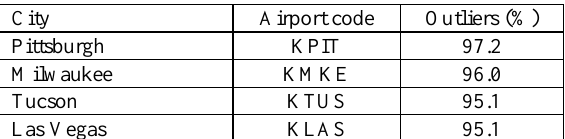
Table 1. Percentage of outliers in the SRTM data for the investigated